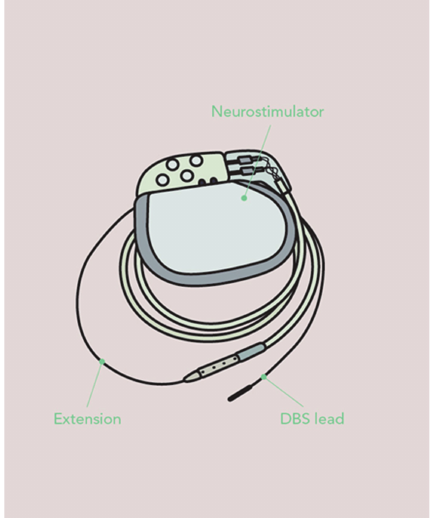
Figure 2: Shows a programmable neurostimulator with a deep brain stimulation lead and